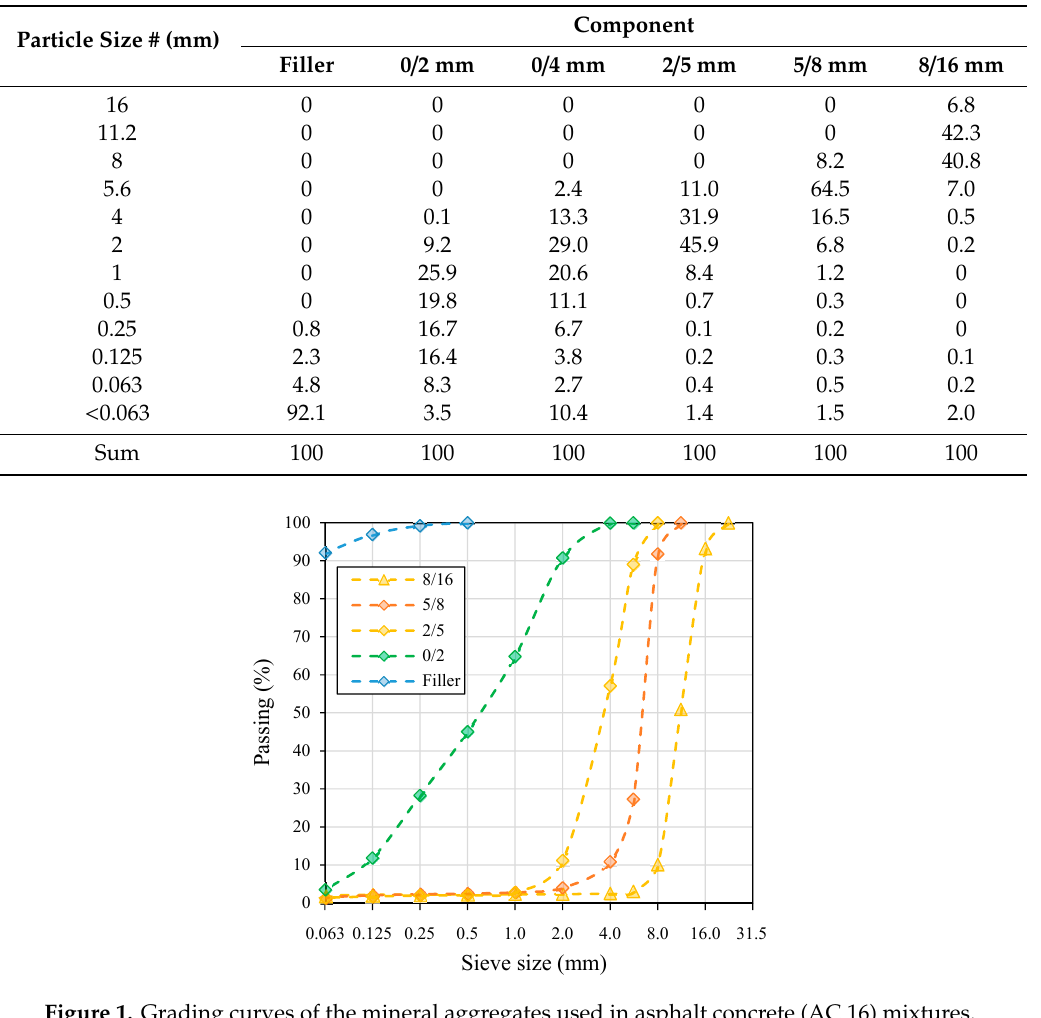
Figure 1. Grading curves of the mineral aggregates used in asphalt concrete (AC 16) mixtures.